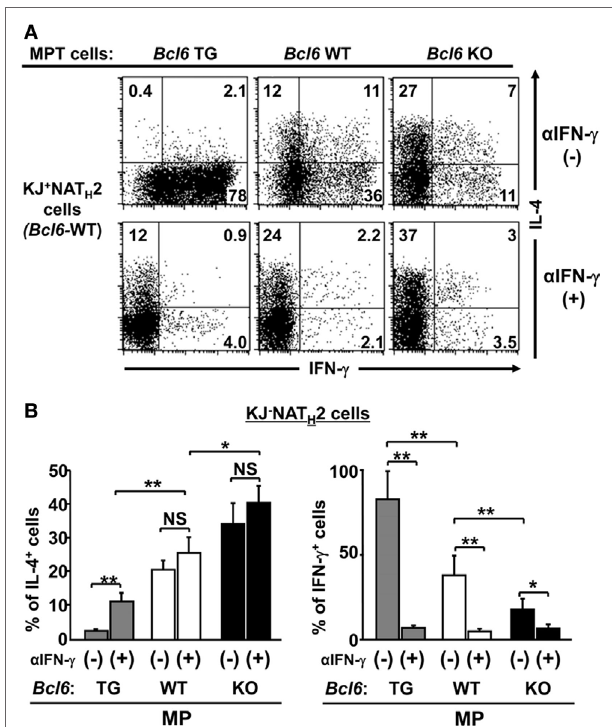
FigUre 6 | Role of Bcl6 in initial IL-4 production by MPT cells to induce NAT H 2 cells in vitro . (a,B) Bcl6 -WT KJ1-26 + naïve CD4 + T cells were cocultured with KJ1-26 − MPT cells ( Bcl6 -TG, Bcl6 -WT, or Bcl6 -KO) in the presence of soluble anti-CD3 and CD28 mAbs and irradiated CD11c + DCs as the T H 0 condition with or without anti-IFN- γ Abs. (a) FACS analysis of intracellular cytokines in each effector T cell type derived from KJ1-26 + naïve CD4 + T cells are presented as a representative figure among three independent experiments after restimulation with anti-CD3 mAbs. Numbers in the corners denote the percentages of gated KJ1-26 + CD4 + T cells. (B) Frequency of the populations of IL-4 + and IFN- γ + KJ1-26 + T cells after reactivation. All results are representative of three independent experiments with similar outcomes. Data are presented as the mean ± SEM ( n = 8–9). * P < 0.05; ** P < 0.01. Ab, antibody; Bcl6, B-cell lymphoma 6; DC, dendritic cell; KO, knockout; mAb, monoclonal antibody; MPT cell, memory phenotype CD4 + T cell; NAT H 2 cell; naïve CD4 + T cell-derived T H 2 cell; TG, transgenic; WT,